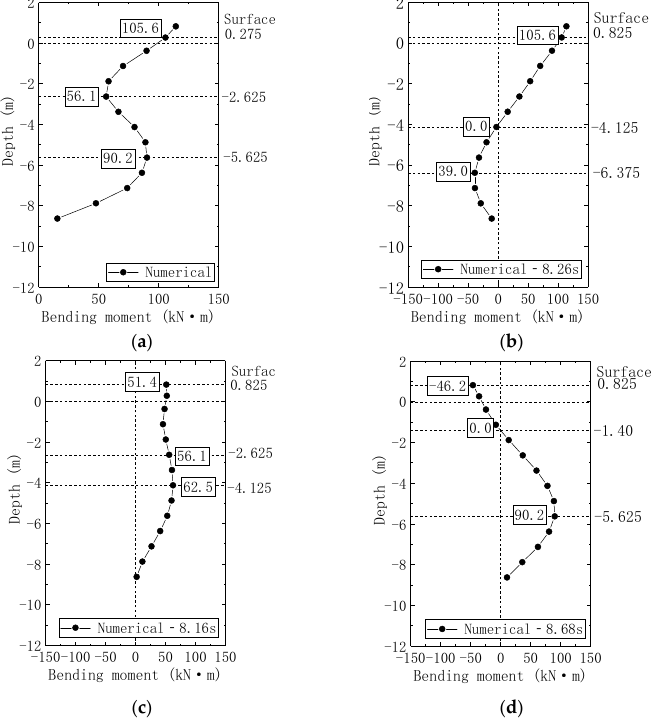
Figure 16. Bending moment and extreme values of Pile 1 at different times: ( a ) Bending moment envelope; ( b ) Bending moment at 8.26 s; ( c ) Bending moment at 8.16 s; ( d ) Bending moment at 8.68 s.